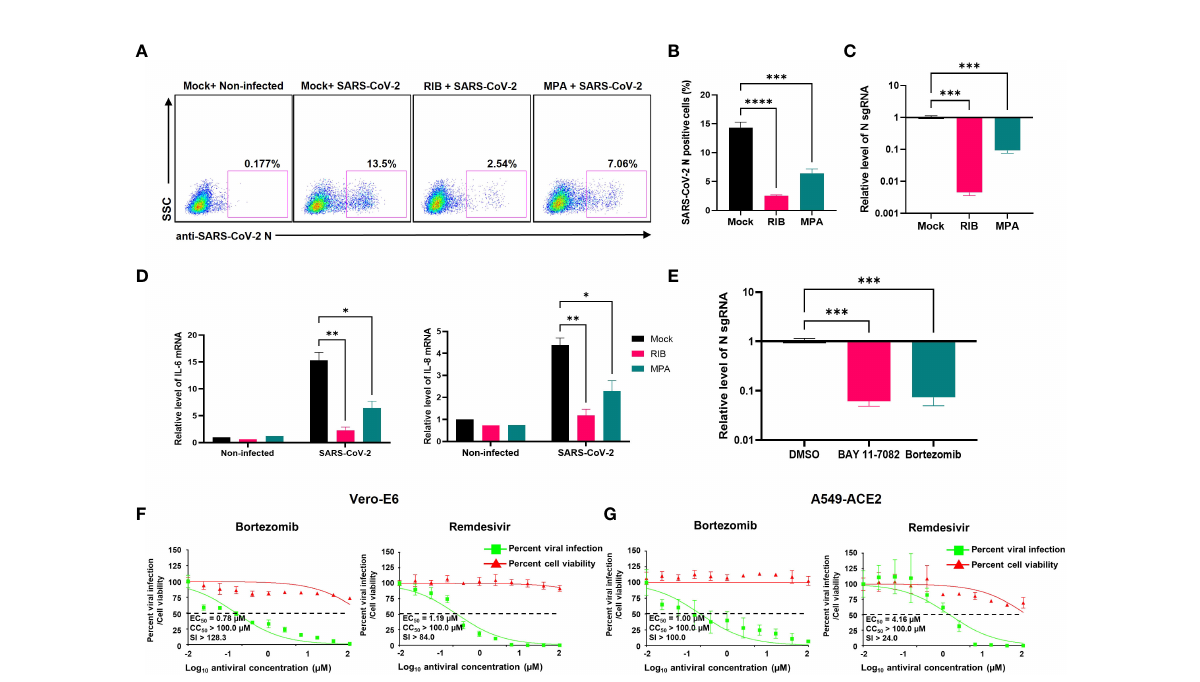
FIGURE 7 IMPDH2 and NF- k B inhibitors restrict the SARS-CoV-2 infection in cell culture. (A-D) A549-ACE2 cells were treated with RIB (500 m M), MPA (100 m M), or mock, and simultaneously infected with SARS-Cov-2 viruses for 24 h. The SARS-CoV-2 infection was detected by intracellular staining of SARS-CoV-2 N protein (A) . The percentage of SARS-CoV-2 N protein-positive cells was calculated (B) . Cells were harvested for RNA extraction, and N protein sgRNA was analyzed and normalized to the mock treatment (C) . The mRNA of IL-6 and IL-8 was analyzed and normalized to the non- infected cell with the mock treatment (D) . (E) HEK293T-ACE2 cells were infected with SARS-CoV-2 in the presence of BAY 11-7082 (10 µM), bortezomib (10 µM), or DMSO solvent control for 24 h. The sgRNA level of N protein was analyzed and normalized to DMSO. Results were calculated from 3 technical repeats and presented as mean +/- standard error of the mean (SEM). (* p<0.05; ** p<0.01; *** p<0.001; **** p<0.001; by one-way (B, C, E) or two-way ANOVA (D) and Tukey ’ s multiple comparison test). (F-G) Vero E6 (F) or A549-ACE2 (G) cells were brie fl y infected with SARS-CoV-2, followed by treatment of indicated compounds (bortezomib, remdesivir). At 24 hpi, the above cells were subjected to PRMNT assay at four biological replicates. Results were calculated as mean +/- standard deviation (SD). The dotted line indicates the 50% inhibition. The selectivity index (SI) is presented as CC 50 /EC 50